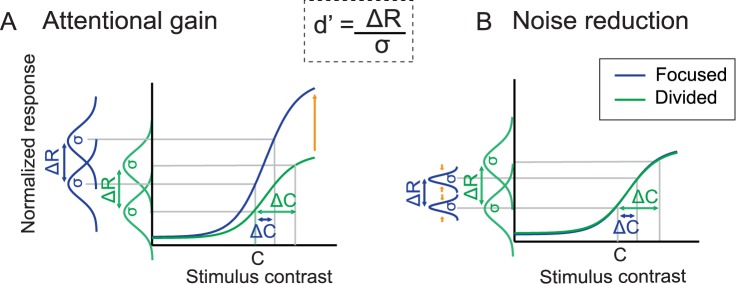
Competing attention mechanisms based on signal detection theory (SDT).According to SDT, perceptual sensitivity (d’) increases via increasing gain (ΔR) and via reducing noise (σ). (A) Attentional gain models posit that selective attention enhances the magnitude of early visual responses (ΔR), which leads to an increase in perceptual sensitivity (d’). (B) Noise reduction models hold that attention reduces trial-by-trial neuronal variability and improves d’ by reducing σ. We hypothesized that training might qualitatively alter the neural mechanisms that support attentional selection, with a shift from attentional gain (A) to noise reduction (B) over time.